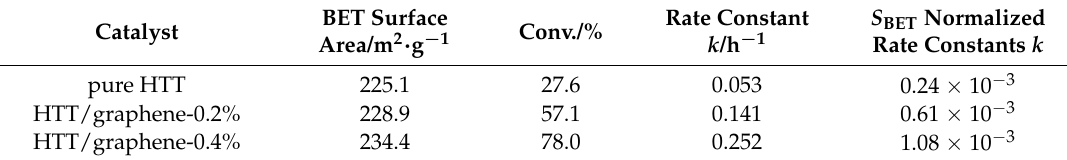
Table 1. Brunauer–Emmett–Teller (BET) surface area of as-prepared HTT/graphene composites and S BET normalized rate constants k for the selective oxidation of benzyl